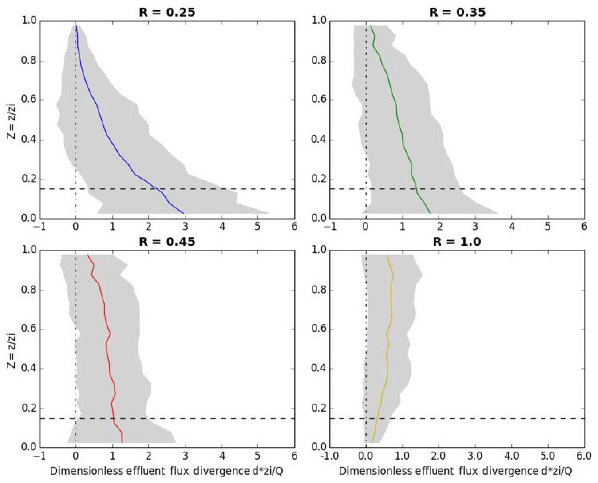
Figure 5. Dimensionless flux divergence profiles generated from averaging over 3 different WRF-LES runs using 30 time steps for each one. The horizontal flux per unit altitude ( d = F/(cid:49)z ) is nor- malized by the boundary layer height, z i , and source strength, Q . The colored profiles are averages at various dimensionless dis- tances, R = 0.1, 0.2, 0.3, and 0.4, and the gray areas represent 1 standard deviation about the mean. The horizontal dashed lines are the approximate lowest safe flight altitude.